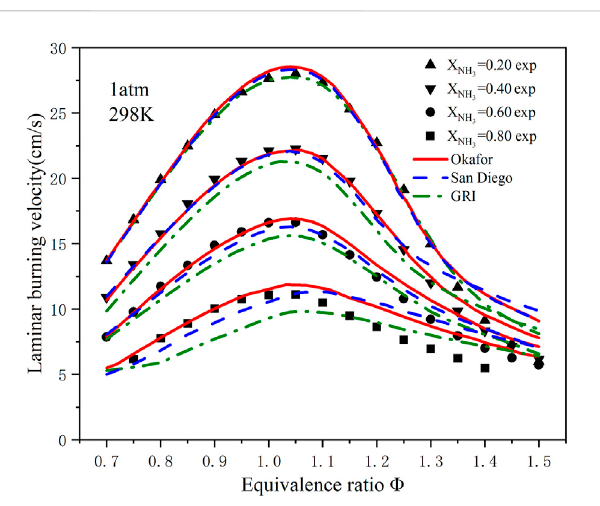
FIGURE 2 Experimentaland simulated LBVs atT=298 K, p =1 atm.(Symbols: experimental data; lines: Simulated